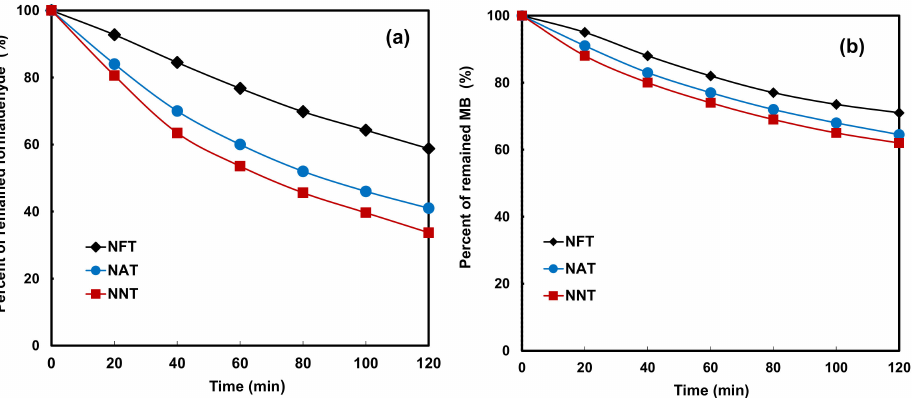
Figure 7. Photocatalytic decomposition of ( a ) formaldehyde and ( b ) methylene blue on NFT, NAT, and